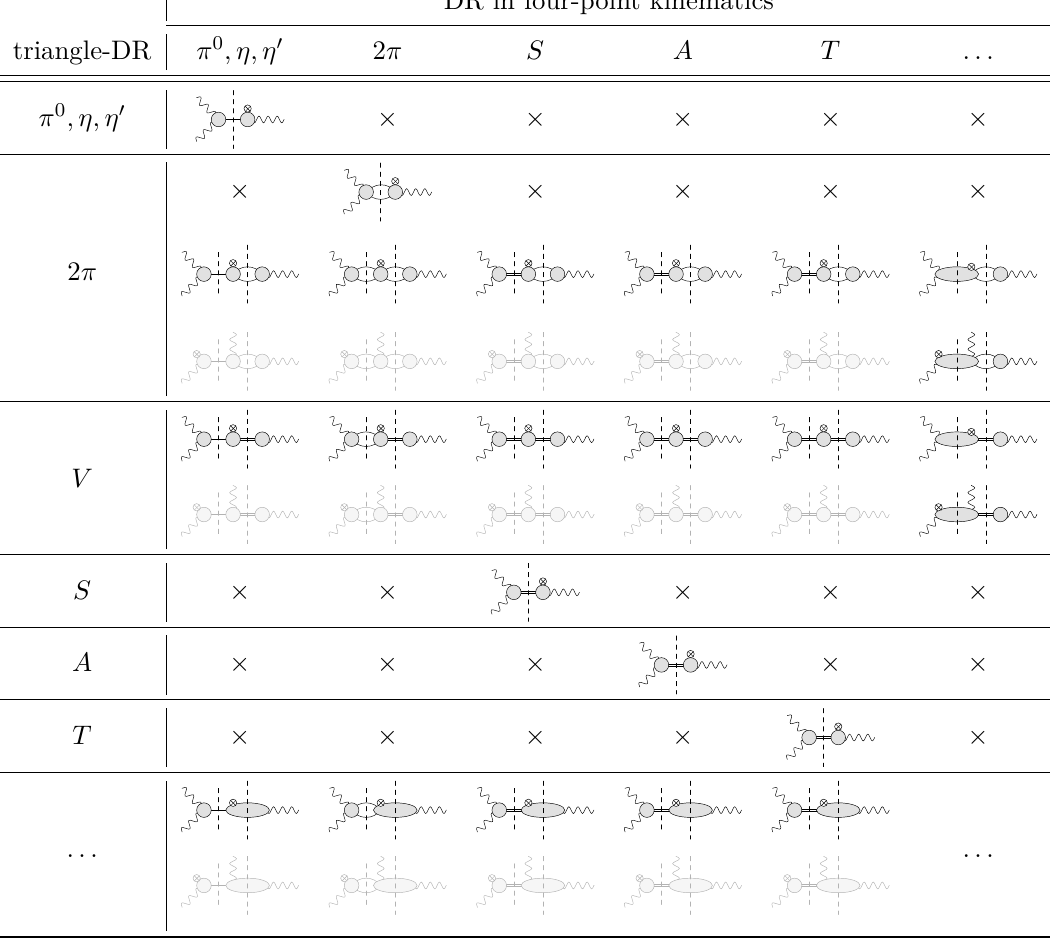
Table 1 . Comparison of different unitarity contributions in the established dispersive approach and the proposed dispersion relations in triangle kinematics. The soft external photon is denoted by a crossed circle. The longer dashed line is the primary cut in triangle-kinematics dispersion relations. Cuts through gray blobs denote even higher intermediate states that need to be covered via the implementation of asymptotic constraints. Some scalar and tensor resonances correspond to a NWA of two-pion contributions. Depending on the dispersion relation for the sub-processes, the diagrams in the first row of the V intermediate state only contribute to normalizations. The light-gray diagrams are already taken into account by implementing crossing symmetry (which is not shown explicitly), hence these topologies should be excluded in order to avoid a double